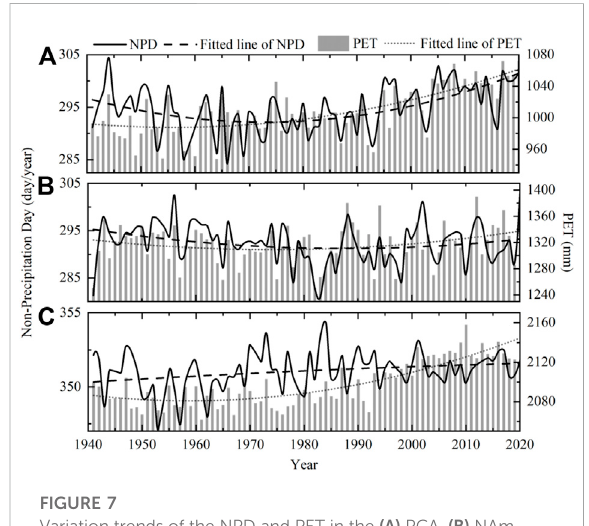
FIGURE 7 Variation trends of the NPD and PET in the (A) PCA, (B) NAm and (C) NAf from 1941 to